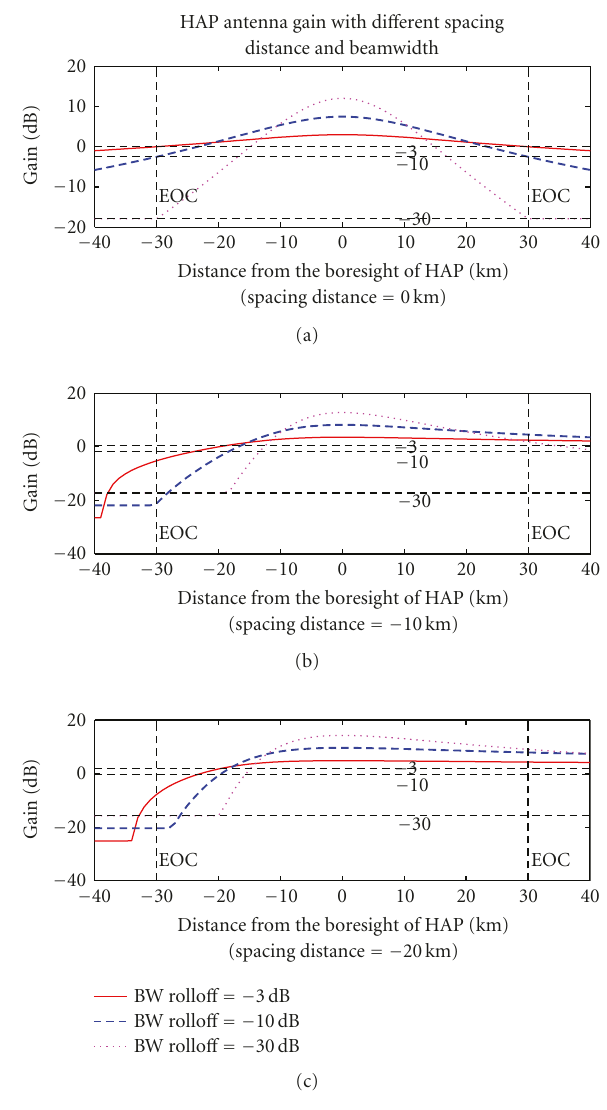
Figure 8: HAP antenna gain with di ff erent spacing distance (0km, − 10 km, − 20 km) and di ff erent beamwidth (BW) roll-o ff ( − 3dB, − 10 dB, − 30 dB).